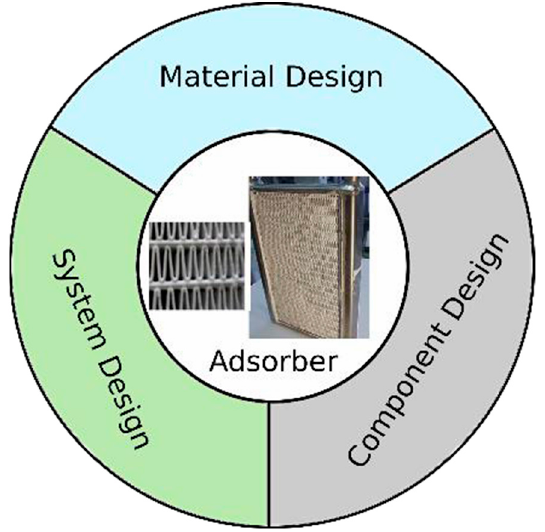
Figure 1. Scheme of an adsorber design approach.